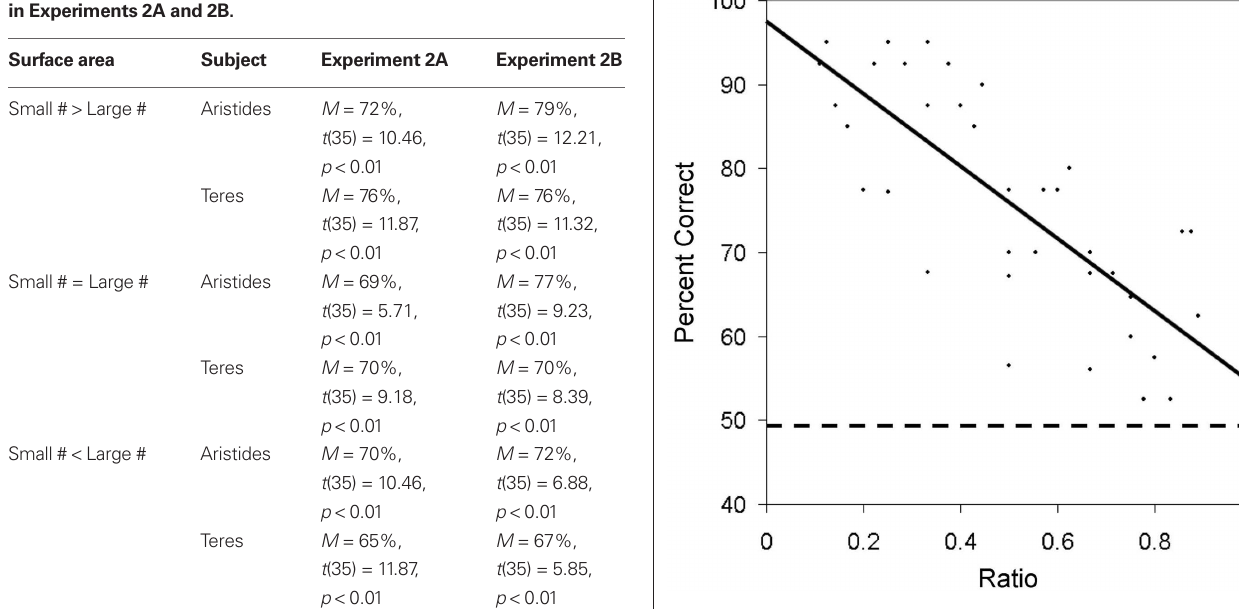
Table 3 | Transfer accuracy during three surface area control conditions in experiments 2A and 2B.